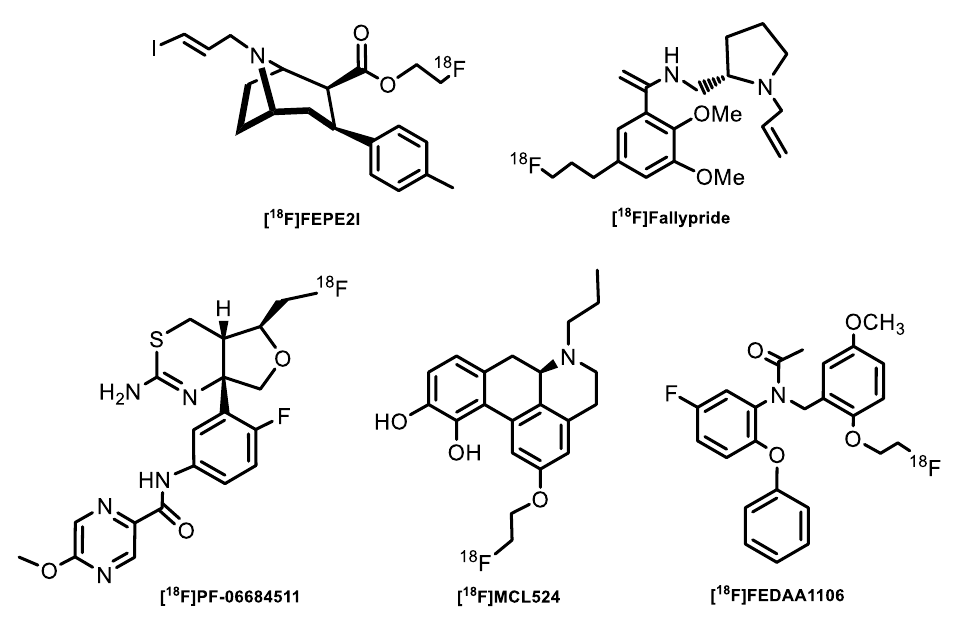
Figure 2. The structures of PET brain radioligands prepared by aliphatic radiofluorination. Pascali and co-authors [25,26] have reported an azeotropic-drying free method using Wester and co-workers [27] described an approach using highly concentrated K 2.2.2. QMA eluent containing 12% of water in acetonitrile with less basic KHCO 3 . The [ 18 F]F − retained on the cartridge (QMA, 130 mg) was eluted with 1 mL of K 2 . 2 . 2 ./KHCO 3 solution;